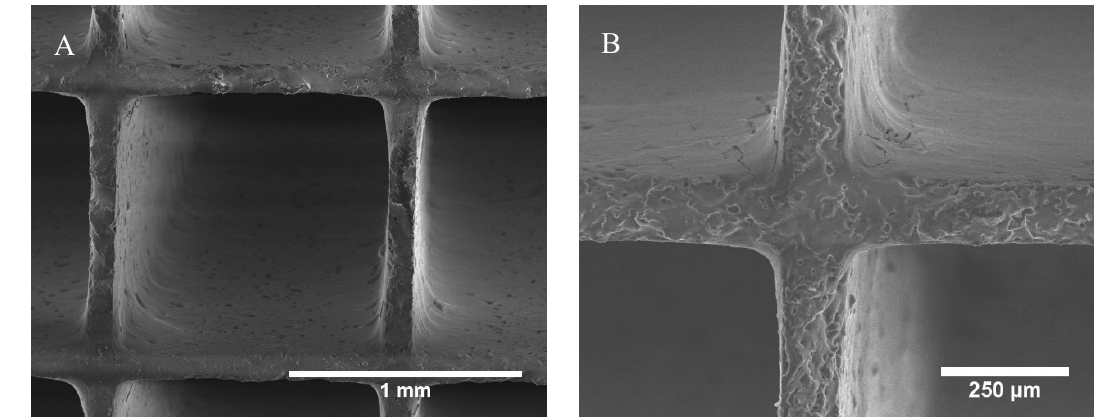
Table 1. Textural properties and CO uptake of PdO/CeO 2 / γ -AlOOH/ γ -Al 2 O 3 monolith catalysts with varying Ce